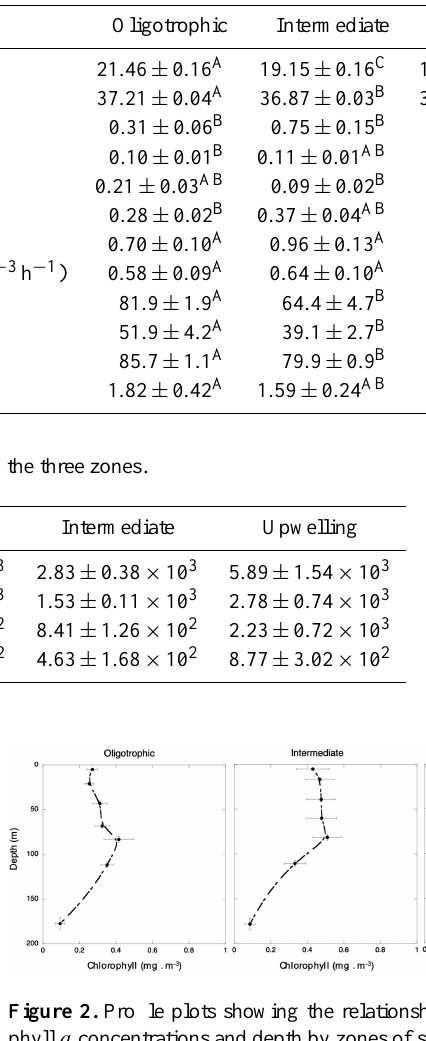
Table 1. Average ± SE hydrological properties, nutrients and chlorophyll a concentration, primary production rates, percentage of phy- toplankton extracellular carbon release (PER), health status of phytoplankton and heterotrophic bacteria and DOC flux per bacteria cell quantified at the three zones. The average values for the zones connected by the same letter are not significantly different (Wilcoxon signed- rank test, p < 0 . 05), and those for the zones connected by a different letter are significantly different ( p < 0 . 05).